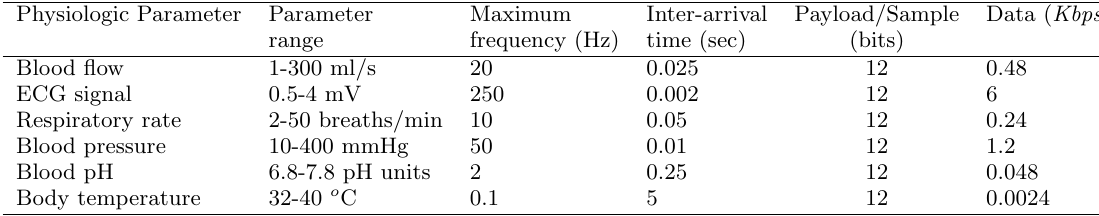
Table 1: Physiologic data characteristics [4].